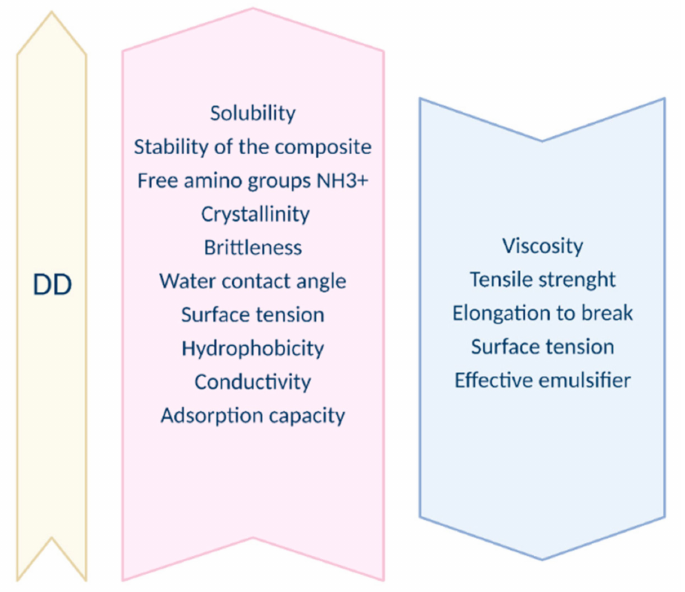
Figure 1. DD influence on physical and chemical properties.